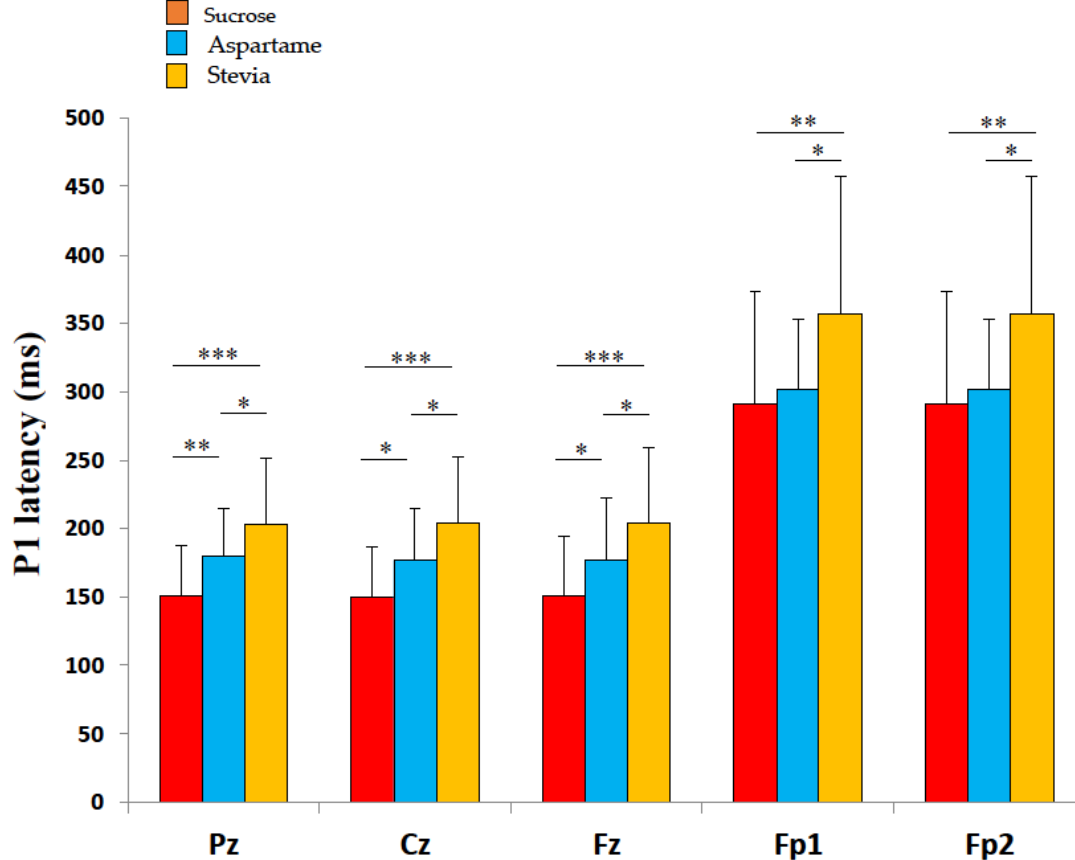
Figure 3. Mean ( ± SD) P1 latency of the gustatory evoked potentials (GEPs) of the 20 subjects, in response to the three sweet solutions: Sucrose 10 g / 100 mL, aspartame 0.05 g / 100 mL, and Stevia 0.03 g / 100 mL of water. P1 latencies of the GEPs di ff ered significantly between the three sweet taste stimuli, for all the recording sites (Pz, Cz, Fz, Fp1, and Fp2). Significant di ff erences in comparisons between the taste solutions obtained with post hoc analyses are expressed as follows: * p < 0.05; ** p < 0.01, *** p < 0.001.